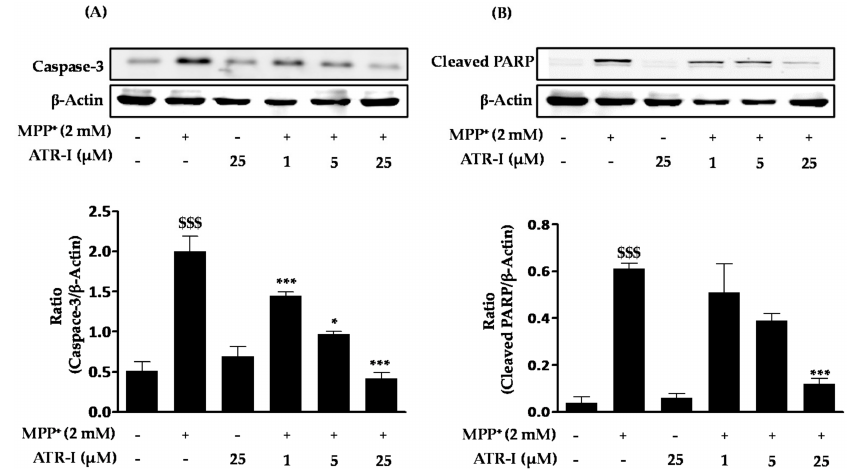
Figure 4. Effect of ATR-I on MPP + -induced expression of caspase-3 and cleaved poly(ADP-ribose) polymerase (PARP) in SH-SY5Y cells. SH-SY5Y cells were tagged with specific antibodies for caspase-3 ( A ) and cleaved PARP ( B ). Quantification of relative expression of caspase-3 and cleaved PARP is provided in the bar graph. β -actin was used as an internal control. $$$ p < 0.001 vs. the vehicle group; *** p < 0.001 and * p < 0.05 vs. the MPP + -treated group.